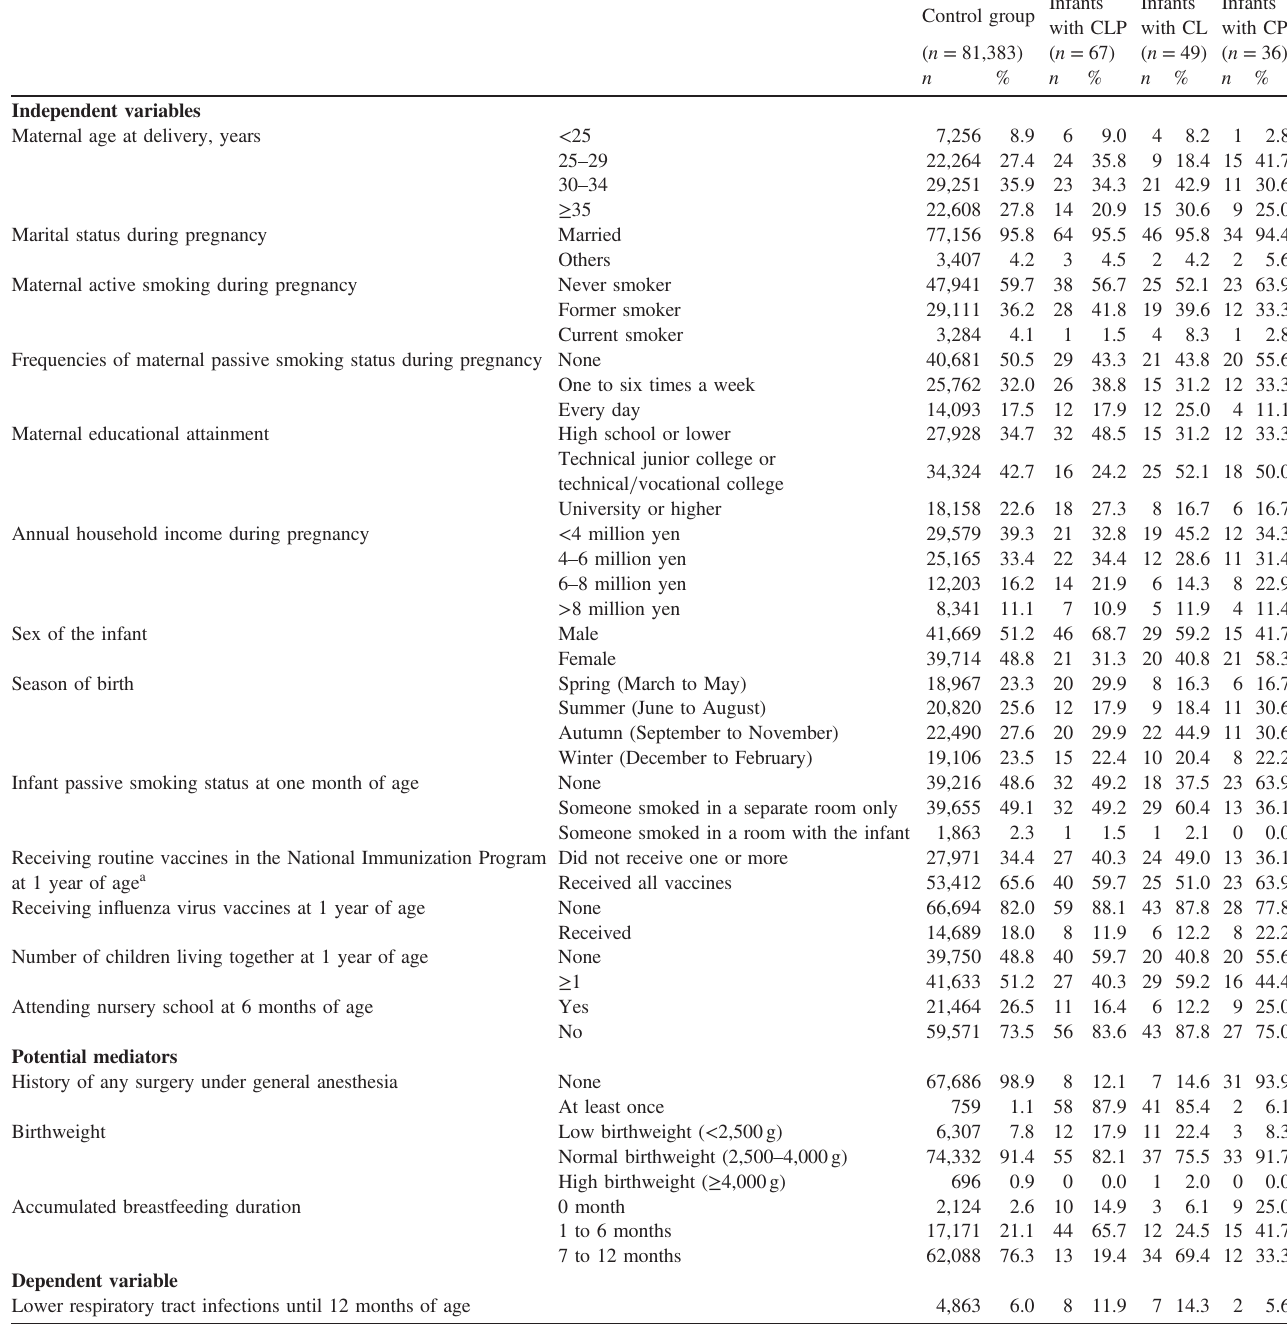
Table 1. Characteristics of the participants according to the type of orofacial clefts